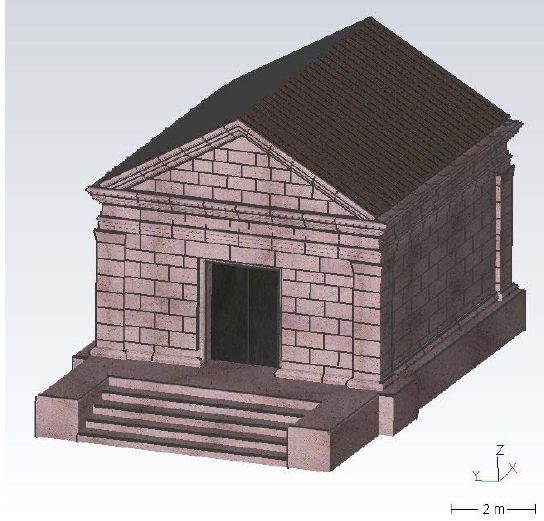
Figure 11: Reconstruction of Meisenbachschloessel from 3D modelled blocks